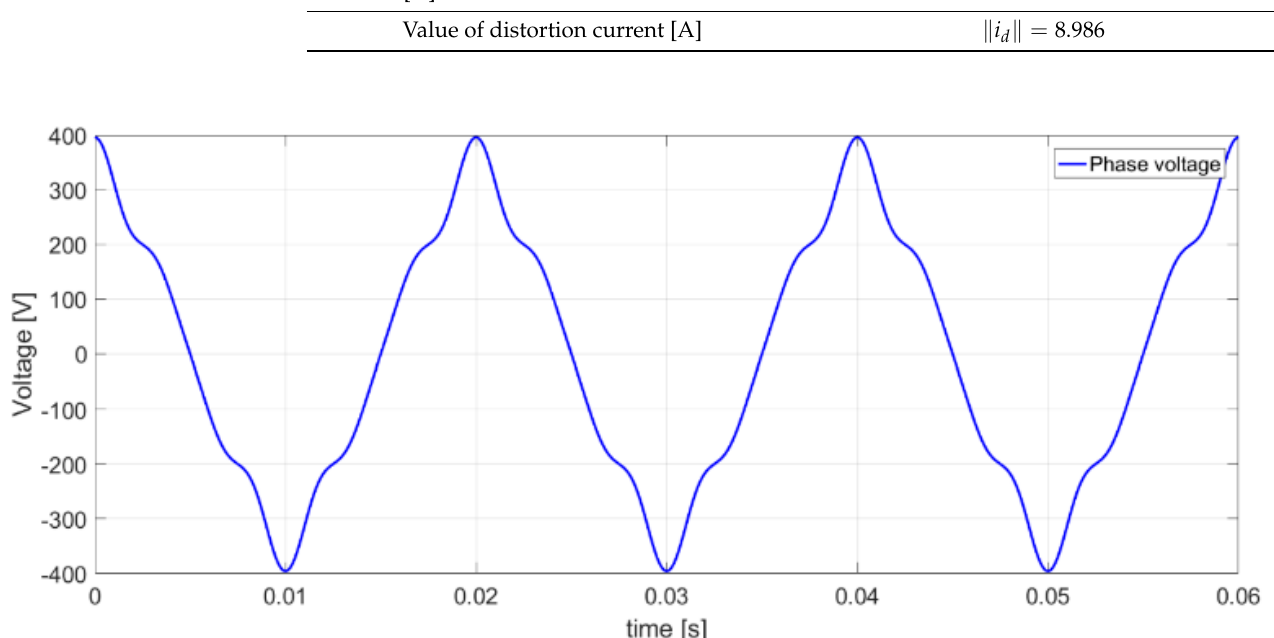
Table 5. List of RMS values of currents in developed Budeanu theory. Budeanu Com-